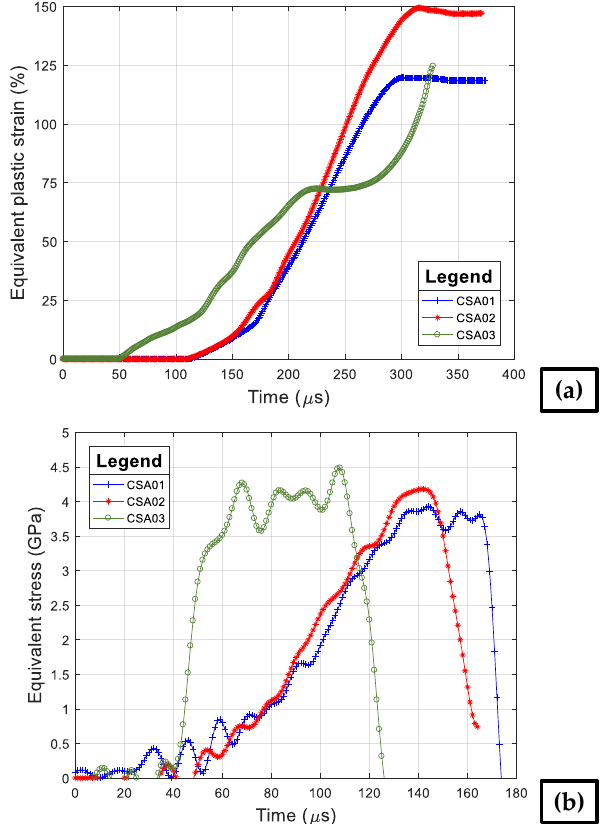
Figure 12. ( a ) Temporal evolution of the dynamic equivalent plastic strain for three dynamic tests. ( b ) Temporal evolution of equivalent stress for three dynamic tests.